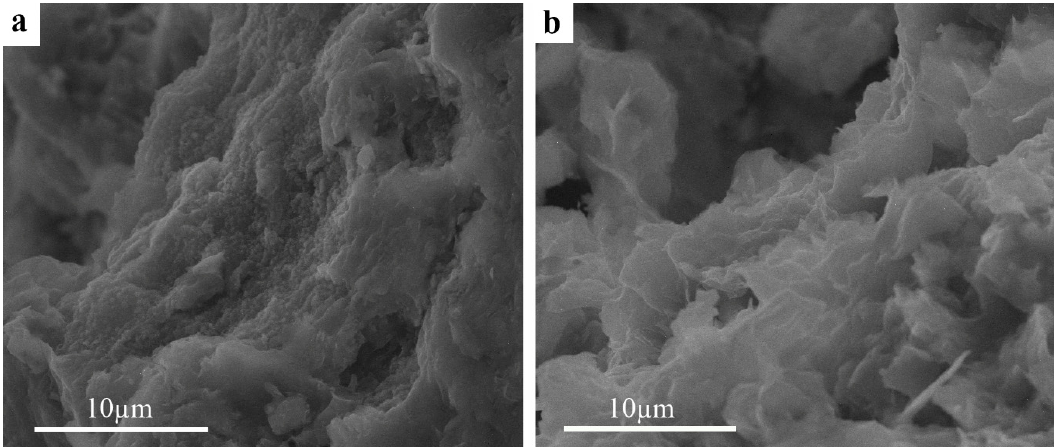
Figure 2. SEM photomicrographs of saponite—( a ) raw and ( b ) acid-treated.